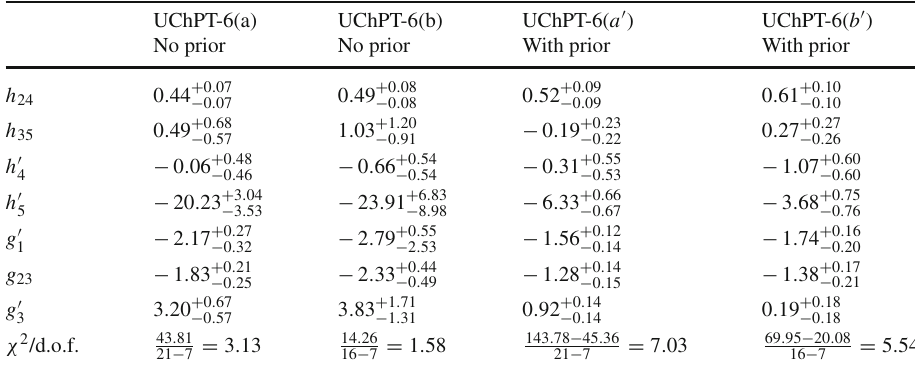
Table4 Decompositionoftheperturbativeamplitudeswithout D ∗ into various types of contributions. The third column is the contribution of LO contact terms. The fourth column collects all loop contributions, including tadpoles and the wave function renormalization. The fifth